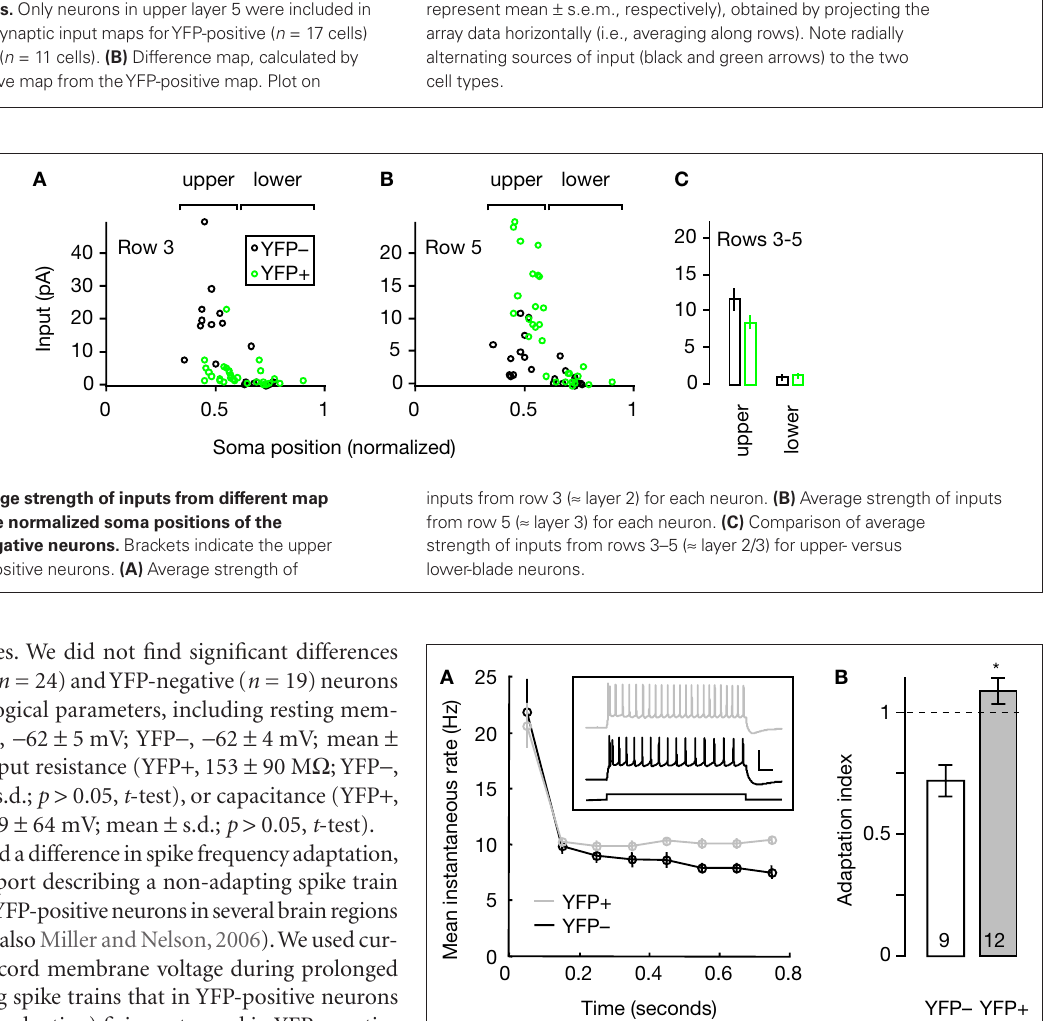
FIGURE 5 | Comparison of spike frequency adaptation in YFP-positive and YFP-negative neurons. (A) Spike latencies were used to calculate instantaneous fi ring rates for the neurons in each group, and these were binned in 100-ms bins for averaging. The plot shows the mean ( ± s.e.m.) instantaneous fi ring rate as a function of time after step onset. Inset shows representative examples of spike patterns of YFP-positive (gray trace) and YFP-negative (black trace) neurons evoked by depolarizing current steps. Scale bars, 0.2 s, 50 mV. (B) Average adaptation index for YFP-negative (open) and YFP-positive (gray) neurons. The group averages were signifi cantly different (*, p < 0.005, t -test). Numbers in bars show sample